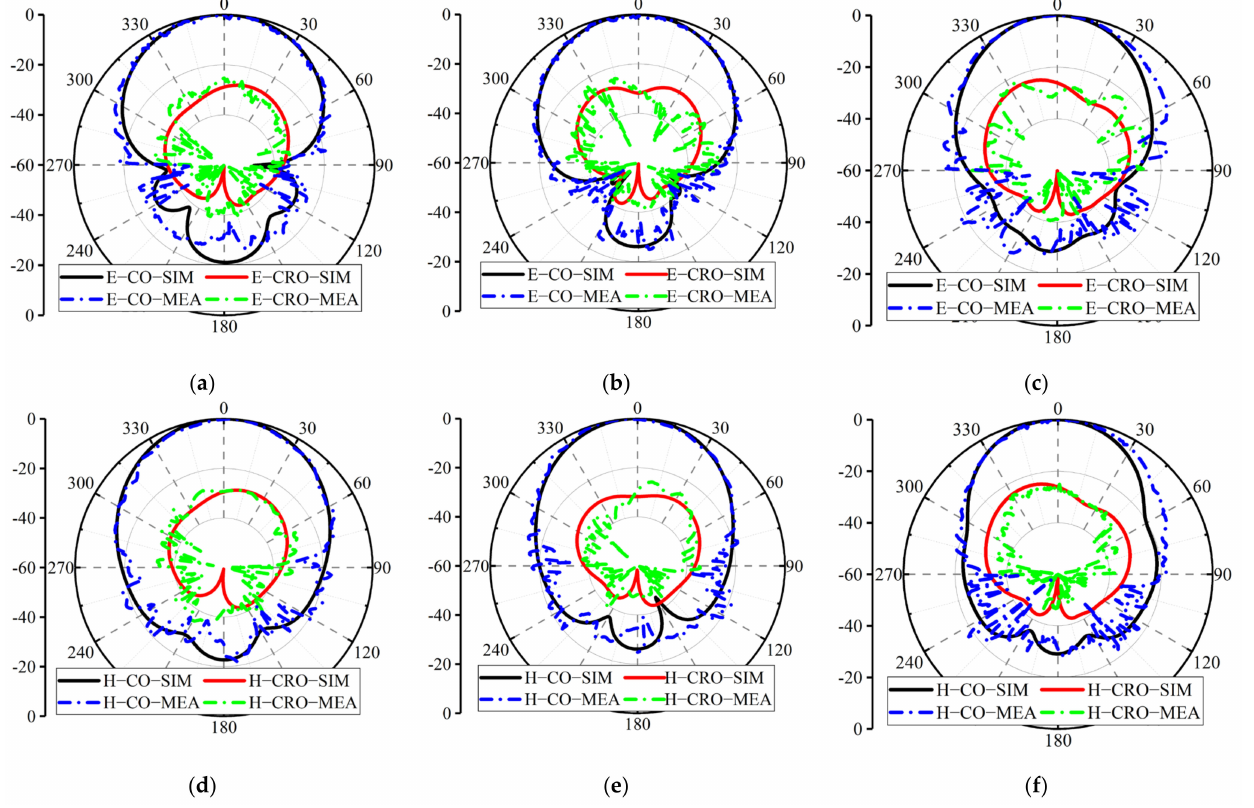
Figure 7. Simulated and measured normalized radiation patterns of port 1: ( a ) E − plane@ 3.3GHz; ( b ) E − plane@ 3.8 GHz; ( c ) E − plane@ 4.3GHz; ( d ) H − plane@ 3.3GHz; ( e ) H − plane@ 3.8GHz; ( f ) H − plane@